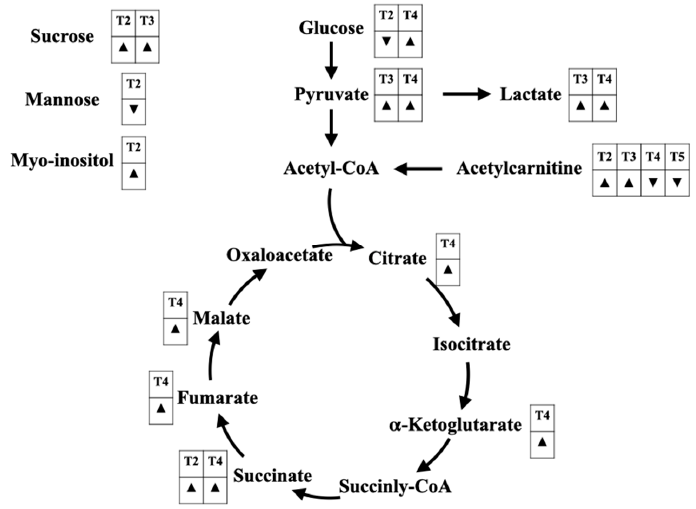
Figure 4. The alterations of glycolysis-related metabolites and tricarboxylic acid (TCA) cycle metab-